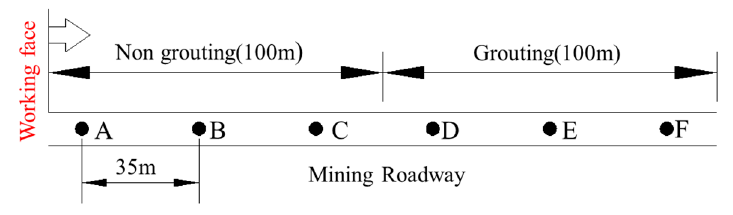
Figure 11. Layout of monitoring points.